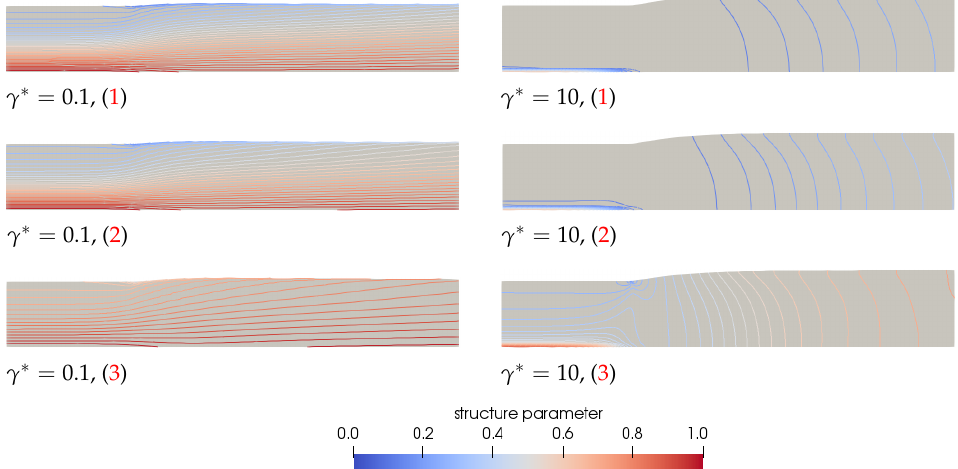
Figure 21. Contour plots of the structure parameter ξ predicted by the rate-controlled approach for λ θ = 10 λ avg and γ ∗ = 0.1 ( left ) and γ ∗ = 10 ( right ) for different instances in time as indicated by the red numbers in Figure 19 for a fluctuating flowrate Q. The contour plots in this figure are made with equidistant contour lines with an interval of 0.025 for